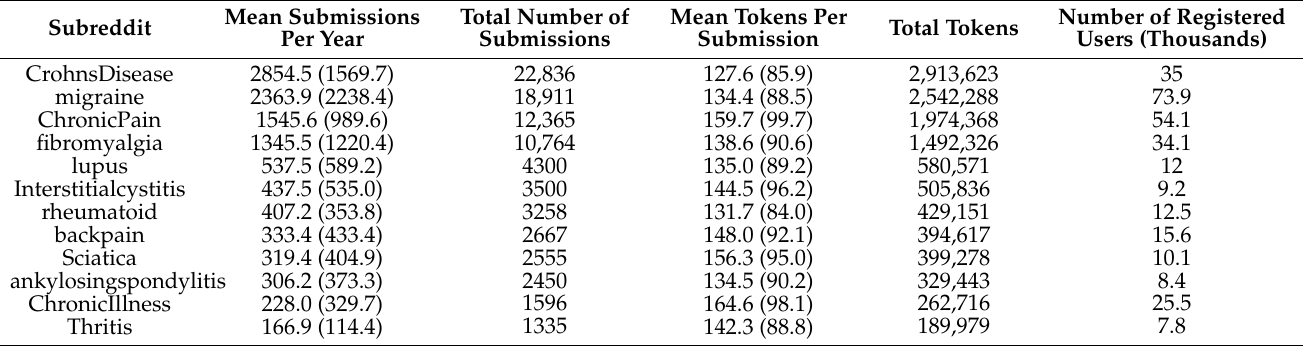
Table 1. Summary of the RRCP dataset regarding textual data per subreddit. Standard deviation is shown in parentheses. Notice that the number of registered users in each subreddit does not have to necessarily match the number of submission authors of that